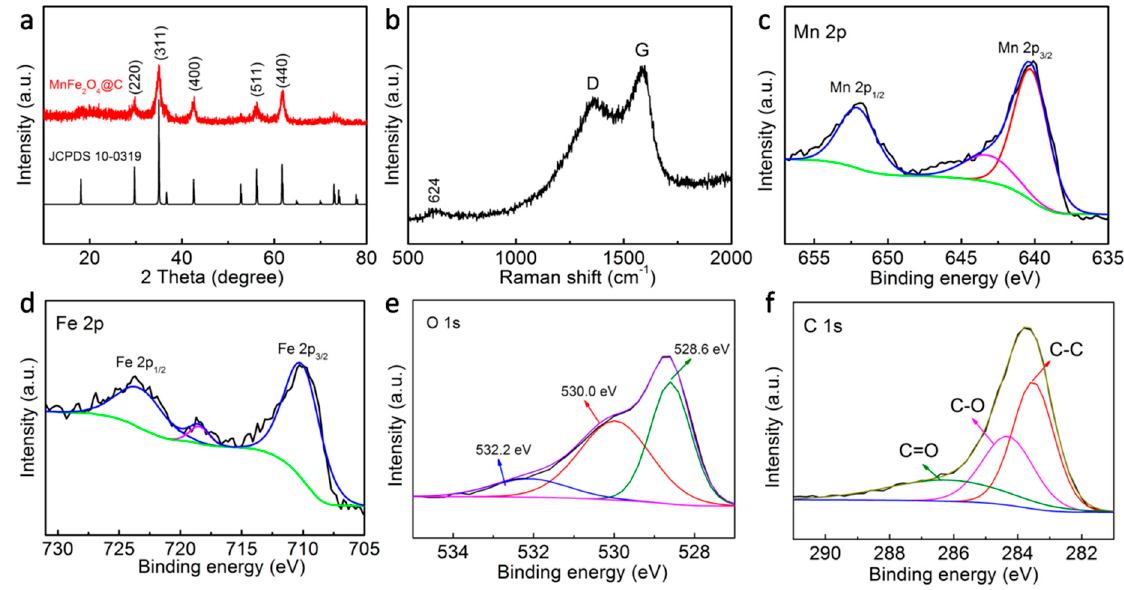
Figure 2. XRD pattern ( a ), Raman spectrum ( b ), XPS spectra for Mn 2p ( c ), Fe 2p ( d ), O 1s ( e ) and C 1s ( f ) of the MnFe 2 O 4 @C composite.